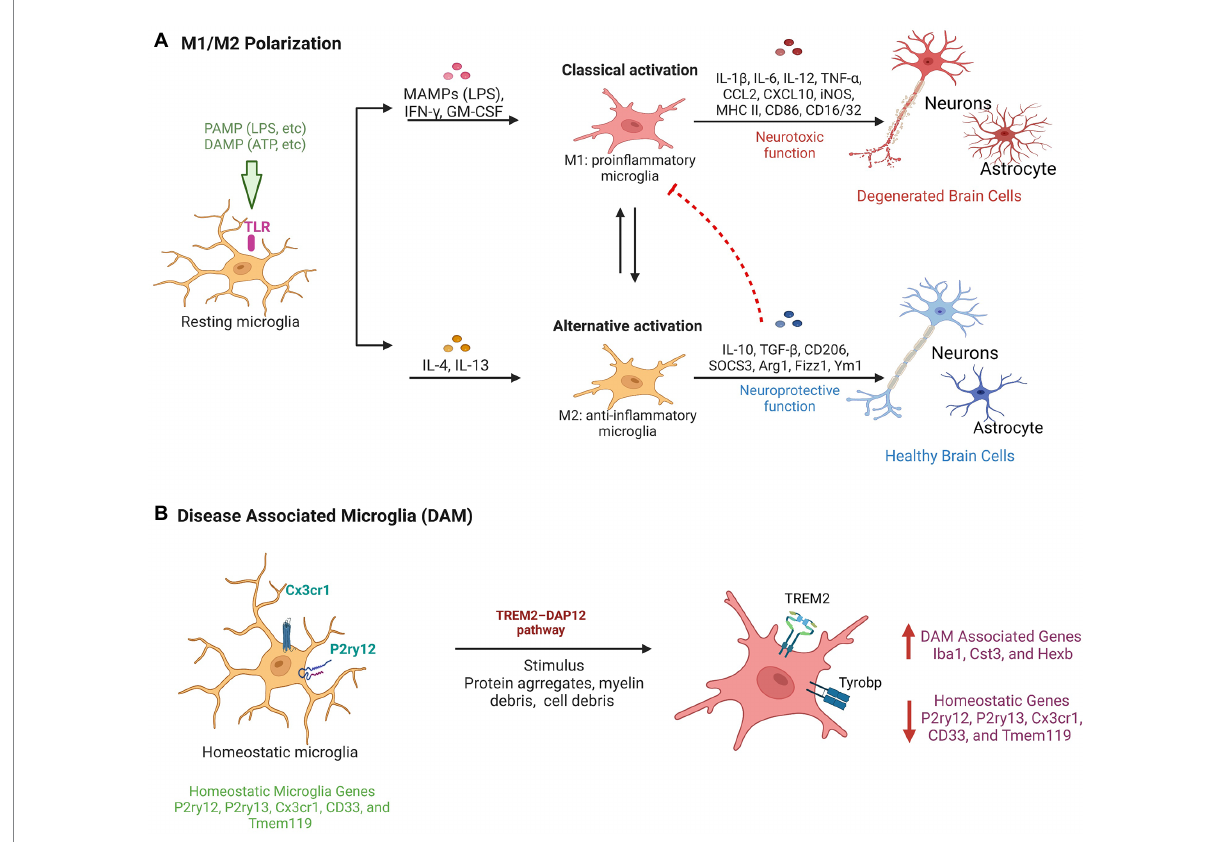
FIGURE 2 Microglial activation pathways in neuroprotection and neurodegeneration. (A) Classical Pathway: PAMPs/DAMPs activate TLRs such as TLR-4 on resting microglia and result in a phenotypic transition to M1 type microglia and secrete pro-inflammatory factors having neurotoxic functions. Alternative pathway: Factors such as IL-4 and IL-13 modulates the transition of microglia to M2 phenotype and provide neuro-protective function by secreting anti-inflammatory cytokines. (B) Diagrammatic representation showing molecular changes in homeostatic microglia leads to their conversion in disease associated microglia phenotype during